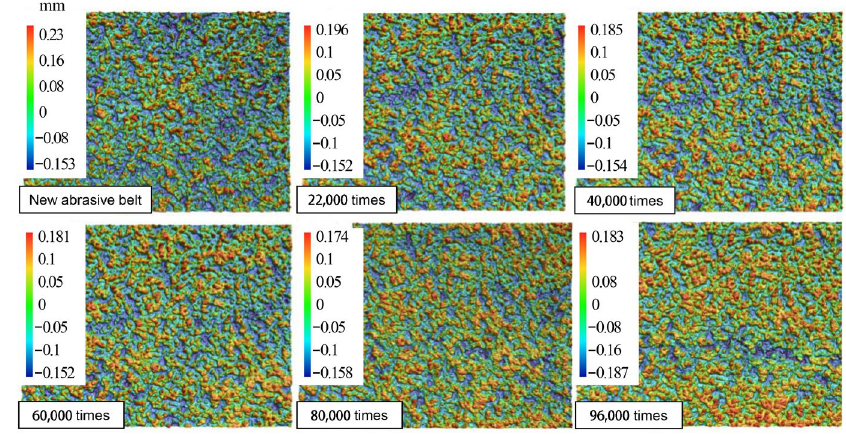
Figure 3. Surface topography of abrasive belt (P60) in MDF sanding.